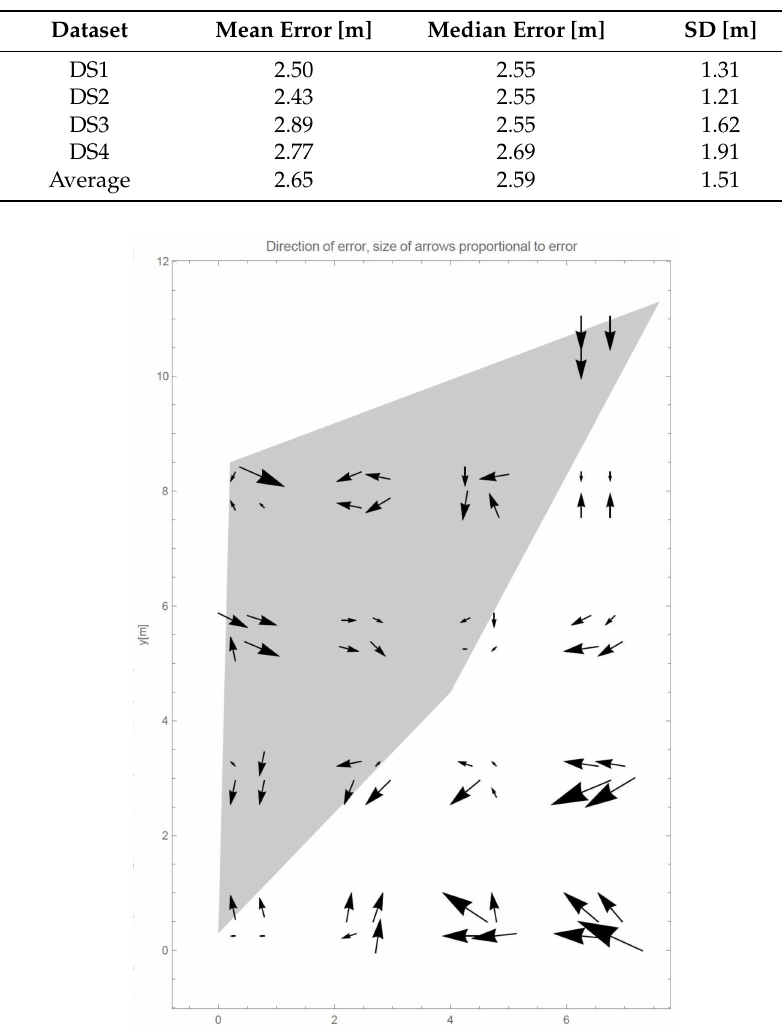
Figure 3. Directions and proportional size of errors for the localization of all four datasets. Gray polygon’s vertices show positions of the Wi-Fi